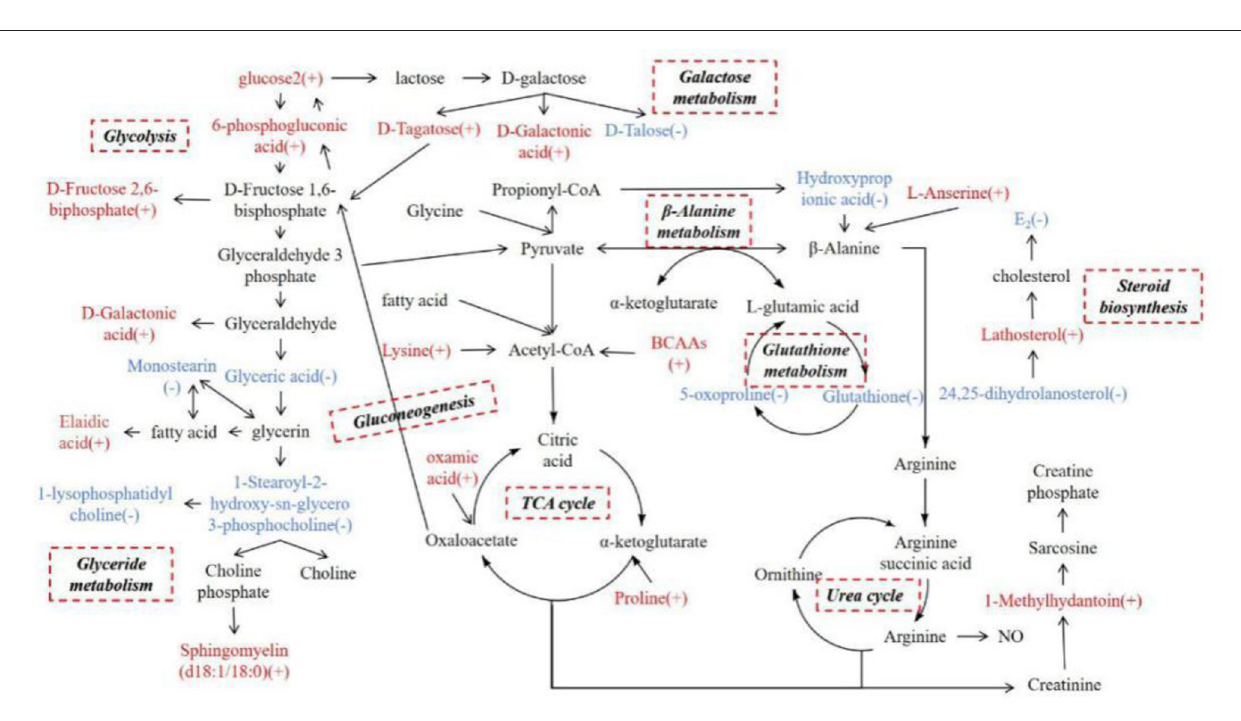
FIGURE 6 | Network metabolic map for total differential metabolites, mainly for glycolysis, galactose metabolism, glyceride metabolism, the TCA cycle, the urea cycle, gluconeogenesis, β -alanine metabolism, glutathione metabolism, and steroid biosynthesis. ( + ) indicates higher concentrations compared with the estrous cows during inactive ovaries; (–) indicates lower